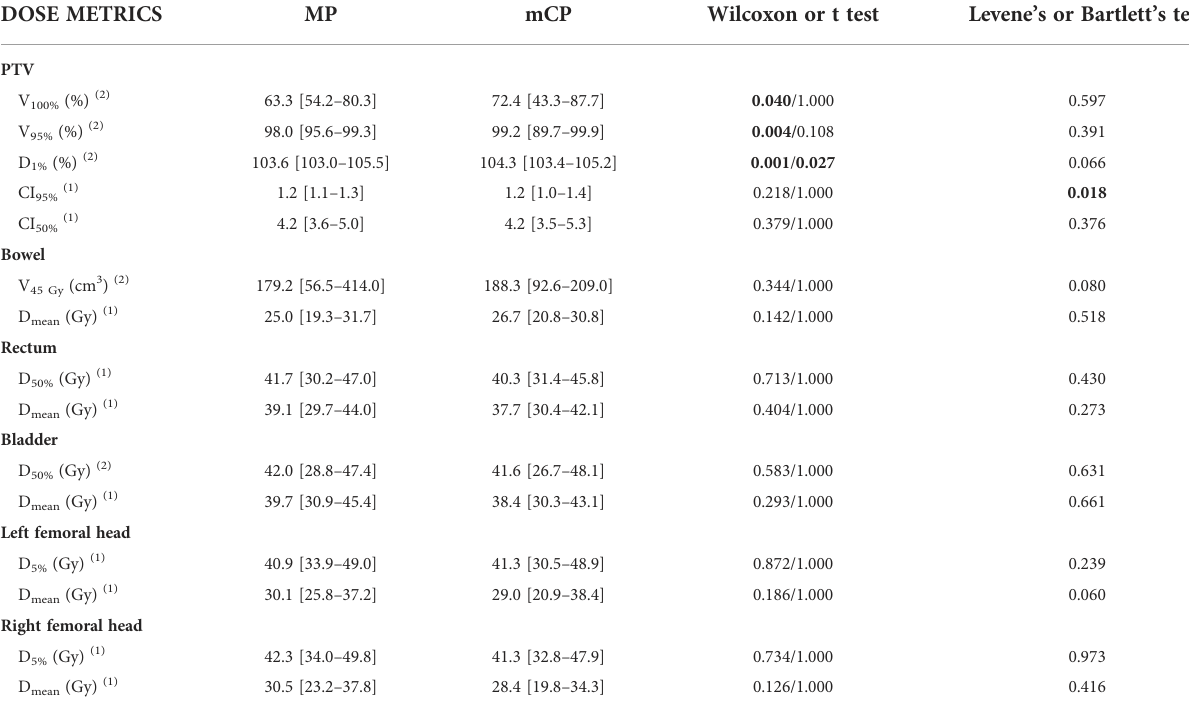
TABLE 2 Comparison of original manual plans and mCycle plans in terms of PTV and OAR dose metrics. DOSE METRICS MP